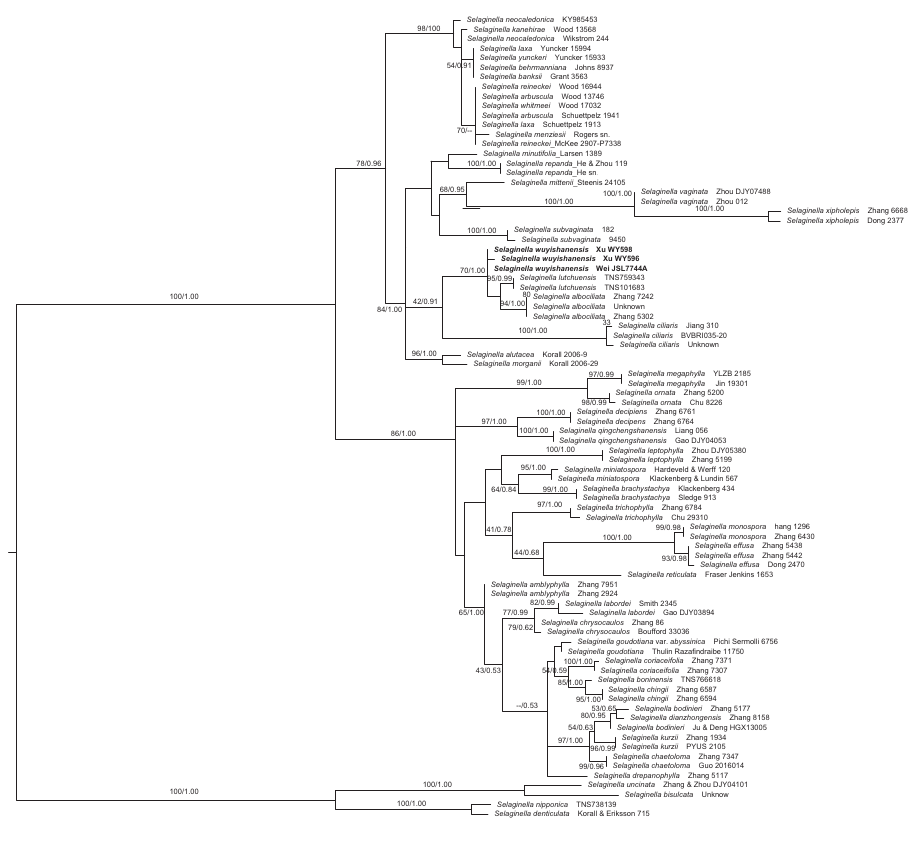
Figure 1. The maximum likelihood phylogeny of Selaginella wuyishanensis and its congeners based on plastid gene rbcL and nuclear locus ITS. Support values [maximum likelihood bootstrap support (MLBS) ≥ 50%, Bayesian inference posterior probability (BIPP) ≥ 0.5] are shown above the main branches. The dash (--) indicates MLBS < 50% or BIPP <